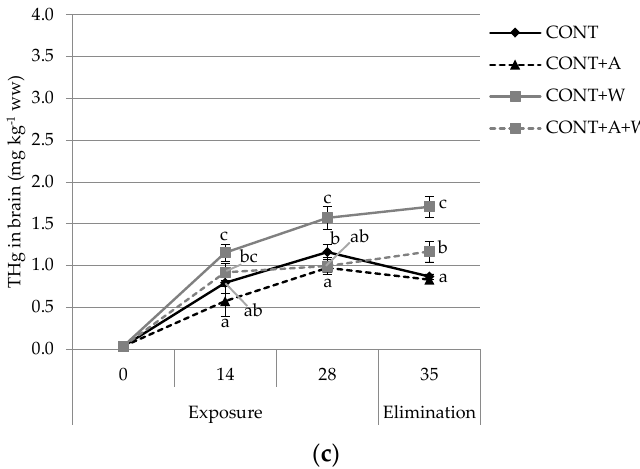
Figure 1. Total mercury (THg) concentrations (mg · kg − 1 wet weight (ww)) in muscle ( a ), liver ( b ), and brain ( c ) of juvenile Solea senegalensis (mean ± standard deviation) fed with Hg-enriched diet in each treatment during the exposure (on days 0, 14, and 28) and elimination (day 35) periods. Abbreviations: CONT—animals fed with Hg-contaminated diet, seawater temperature set at 19 ◦ C, and pH set at 8.0 units.; CONT + A—animals fed with Hg-contaminated diet, seawater temperature set at 19 ◦ C, and pH set at 7.6 units; CONT + W—animals fed with Hg-contaminated diet, seawater temperature set at 23 ◦ C, and pH set at 8.0 units; CONT + A + W—animals fed with Hg-contaminated diet, seawater temperature set at 23 ◦ C, and pH set at 7.6 units. Gray lines indicate temperature set at 23 ◦ C (warming (W)), whereas continuous lines indicate pH set at 8.0 units, and discontinuous lines indicate pH set at 7.6 units (acidification (A)). Di ff erent letters for each sampling day represent significant di ff erences ( p < 0.05) between treatments.